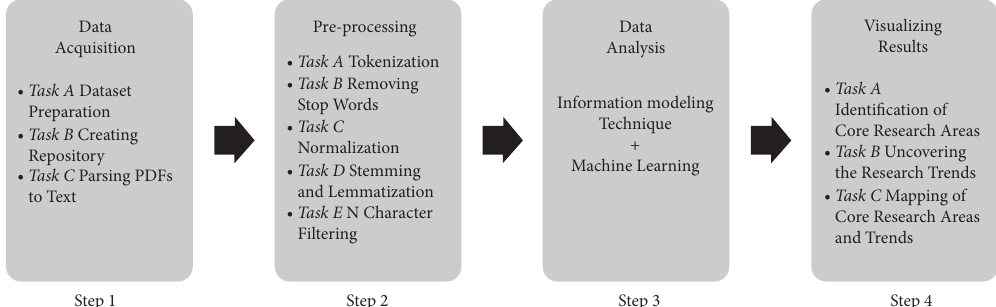
Figure 1: Sequence diagram of SEAR framework.